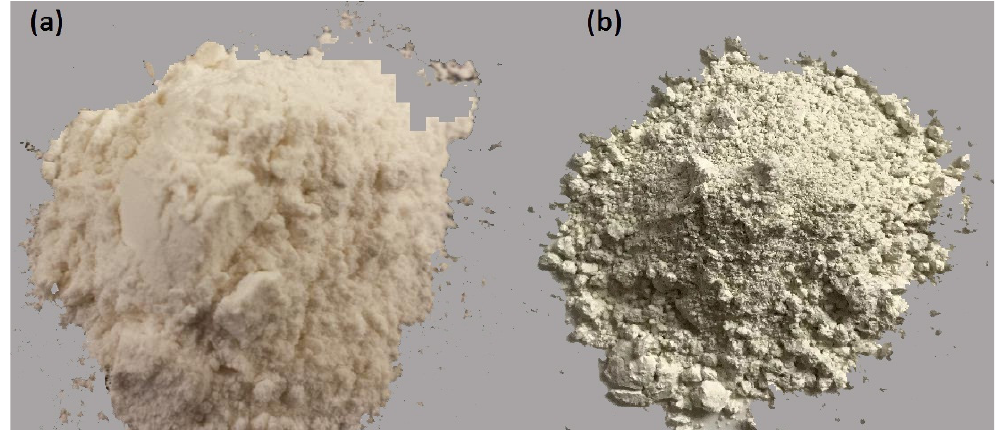
Figure 3. A view of ( a ) nanofiber and ( b ) nanoclay applied in this study.